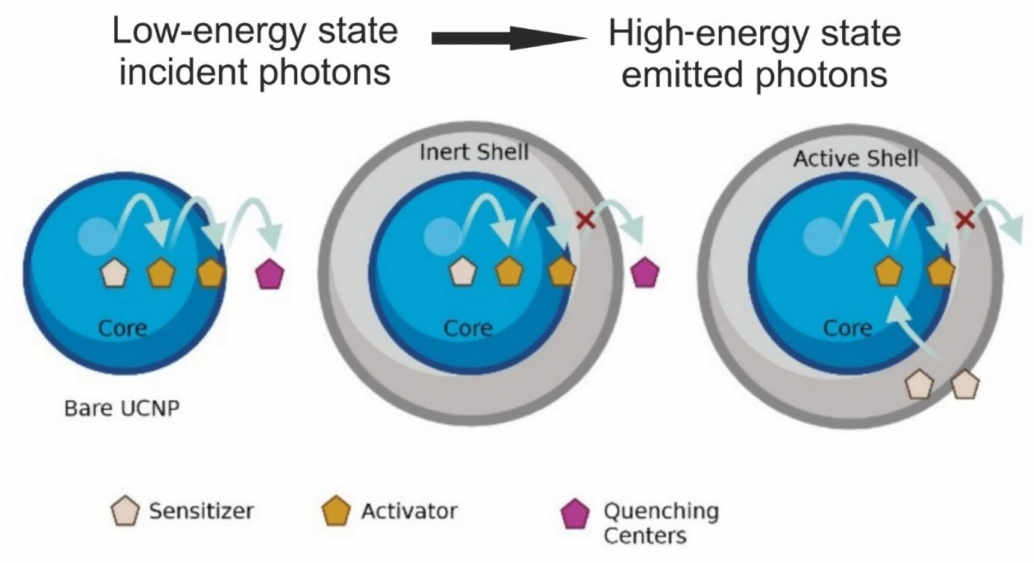
Figure 2. Structure of core–shell upconversion